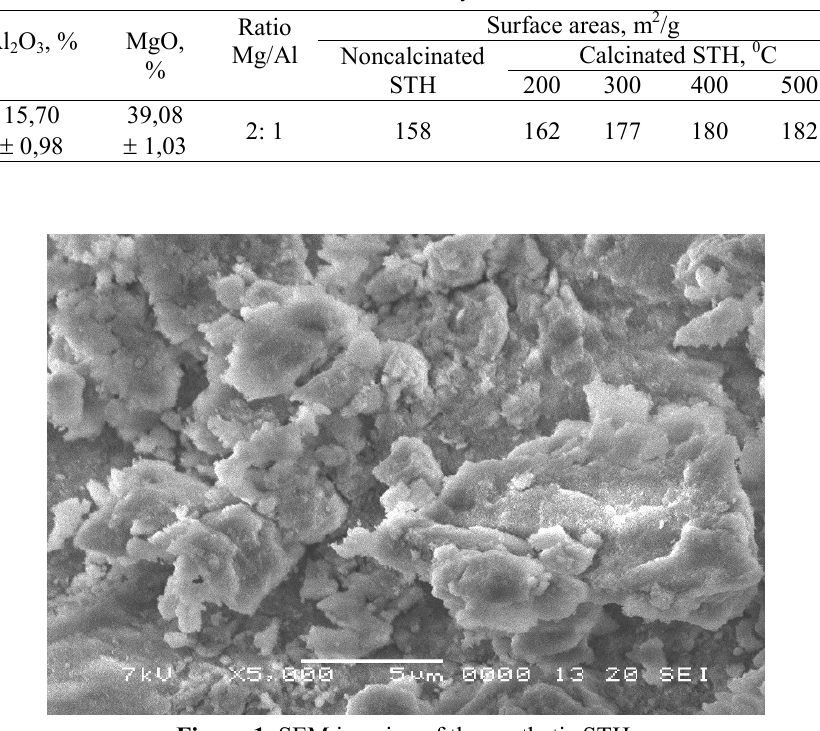
Figure 1. SEM imagine of the synthetic STH.